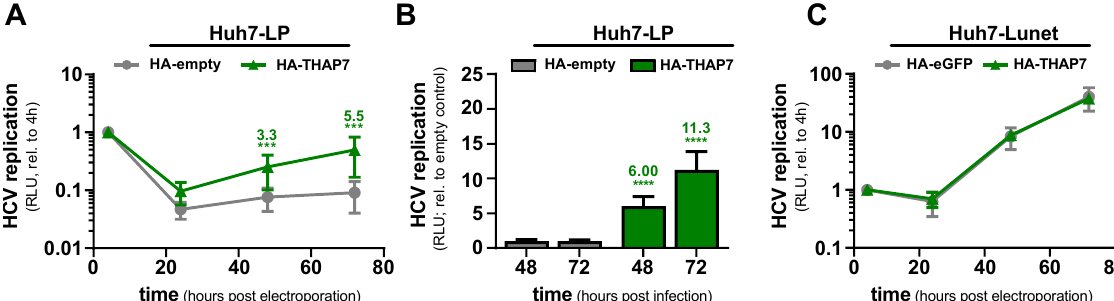
Figure 4. THAP7 is a limiting host factor for HCV replication in lowly but not in highly permissive Huh7 cells. ( A ) Replication of a subgenomic luciferase reporter replicon (gt1b) after electro-transfection into HA-THAP7 overexpressing Huh7-LP cells compared to an HA-empty vector control in a time-course of 72 h. ( B ) Full-length Renilla luciferase reporter virus (JcR2a) replication in HA-THAP7 overexpressing Huh7-LP cells compared to an HA-empty vector control after 48 and 72 h. ( C ) Replication of a subgenomic luciferase reporter replicon (gt1b) after electro-transfection into HA-THAP7 overexpressing Huh7-Lunet cells. HCV replication in ( A , C ) was normalized to the input signal four hours post transfection and ( A–C ) show mean and standard deviation from at least three independent biological experiments. Significance was calculated using two-tailed, non-paired Student’s t -test. *** p ≤ 0.001, **** p ≤